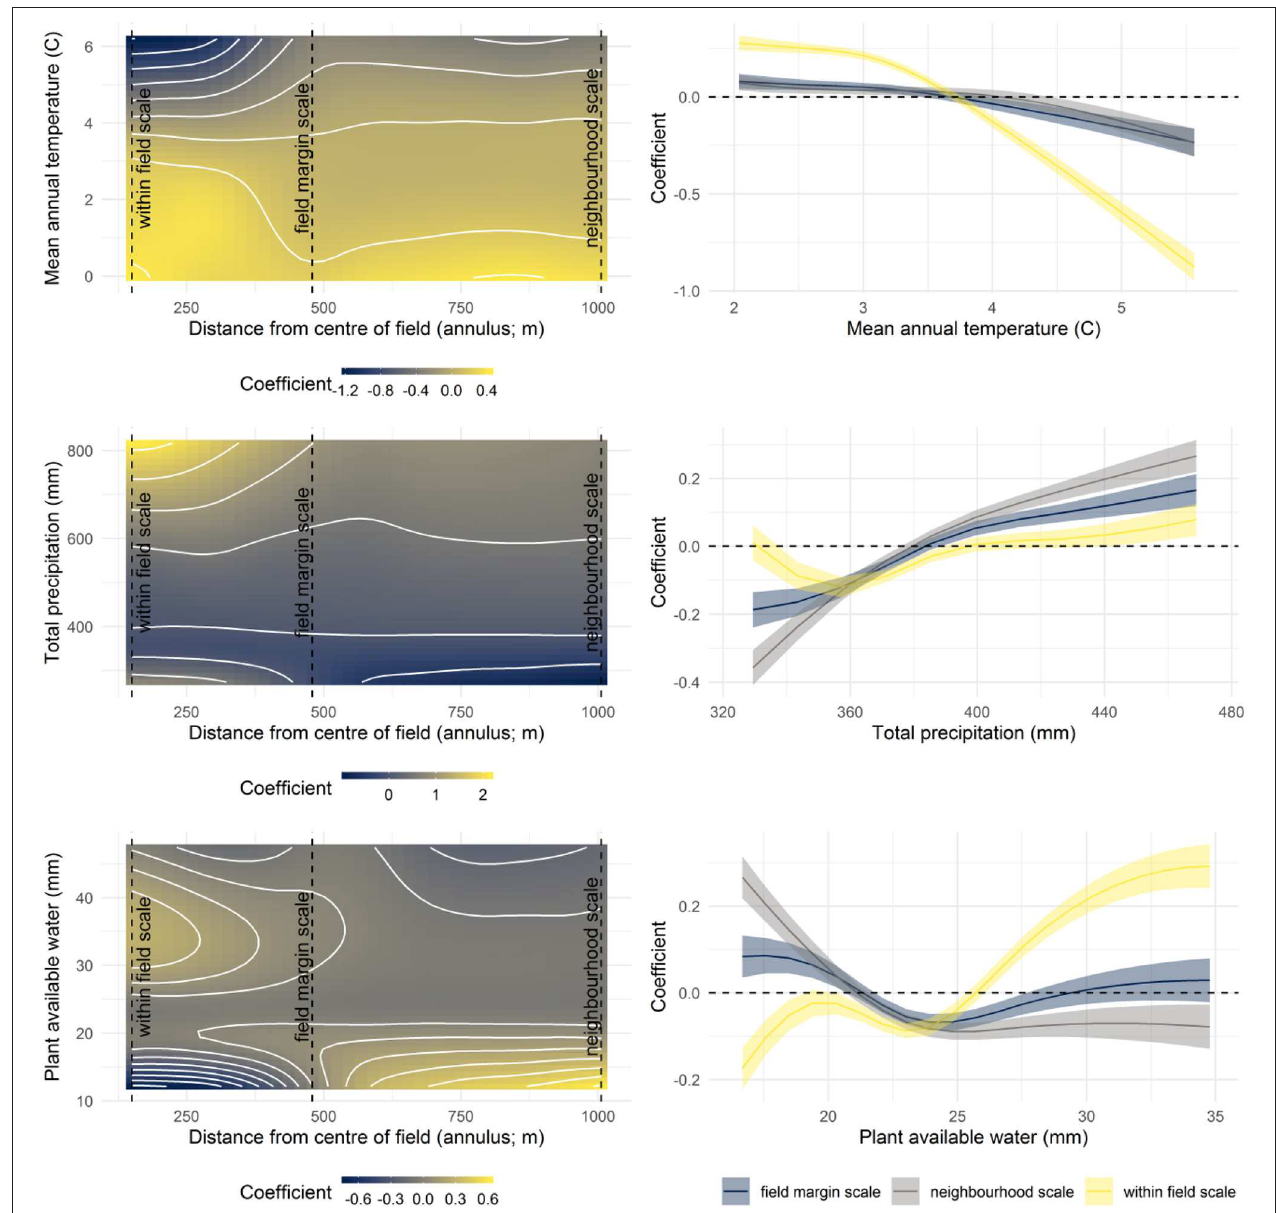
FIGURE 7 | ( Left ) Bivariate coefficient functions for continuous environmental variables, where coefficients give deviations from the mean landscape complexity curve ( Figure 3 ). ( Right ) The effect of the environmental variable across 95% of the observed distribution of that variable shown at three selected scales.